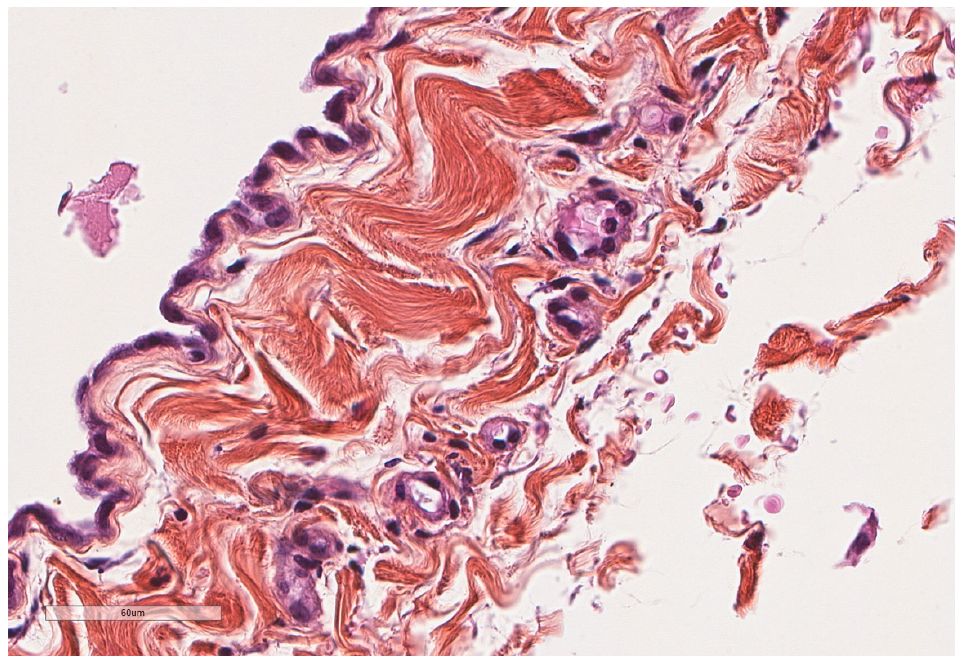
Figure 2. Normal parietal pleura microscopy. At the left side of the image, a single layer of mesothelial cells is seen underlined by a thin connective tissue. Hematoxylin, eosin, saffron staining (×400). The visceral pleura (Figure 3) contains the following order of layers: a very thin